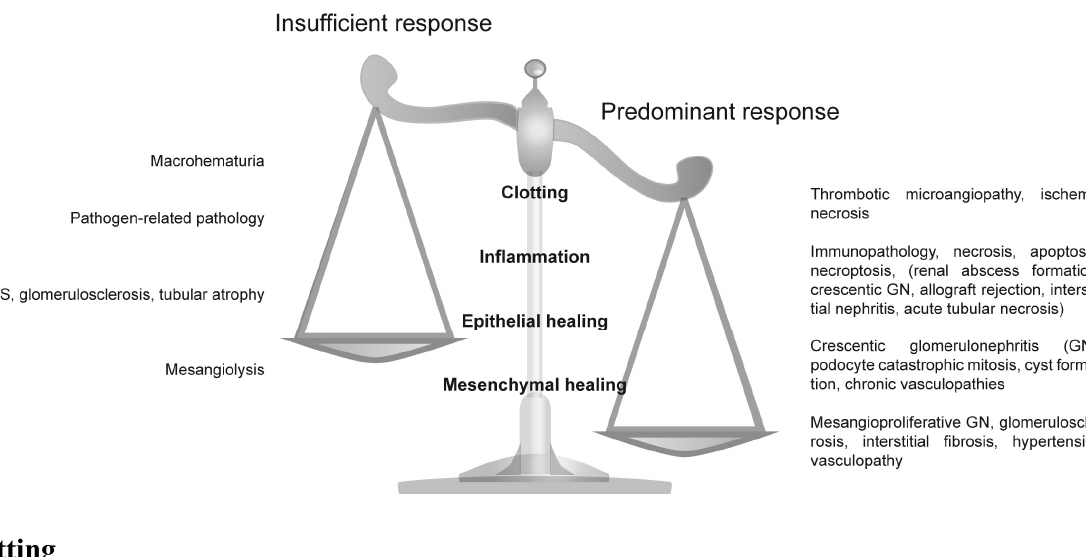
Figure 1. Insufficient and predominant danger response programs determine kidney pathology. Distinct entities of clinical syndromes or kidney injury patterns are consequences of insufficient or overshooting danger control